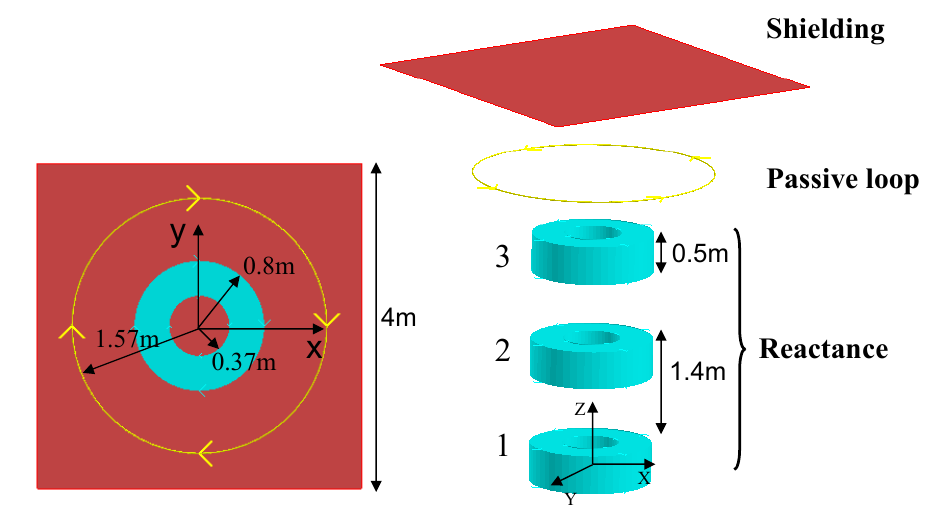
Figure 7. Geometry of the test case “Folies”. Table 2. Current values in the passive loop, where j is an imaginary unit.